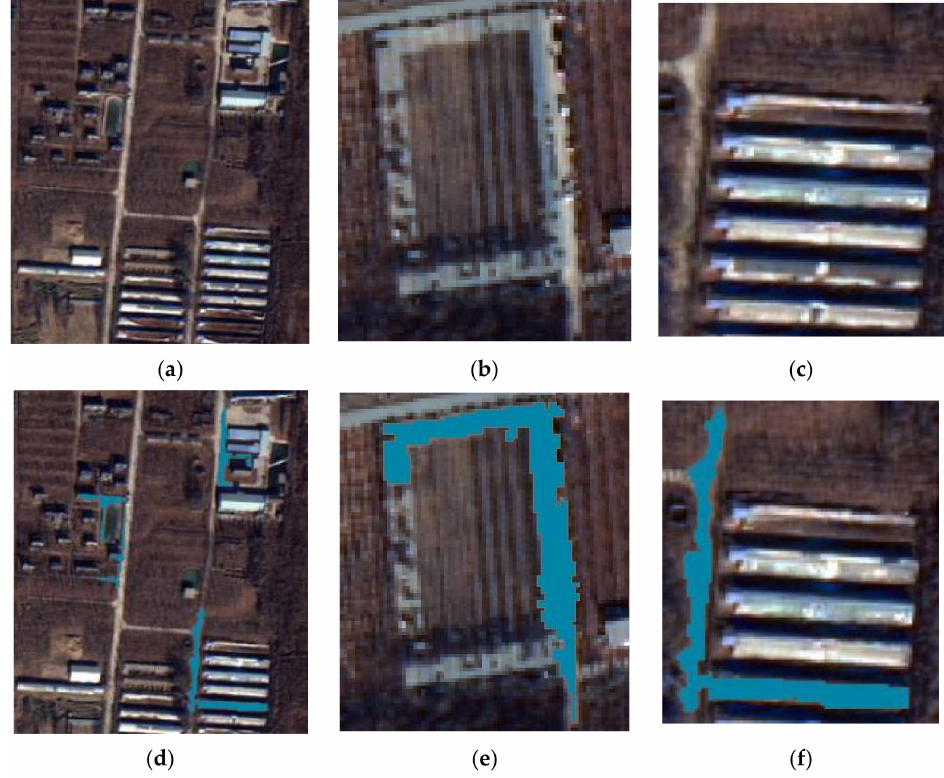
Figure 21. Classification results for the compactness: ( a – f ) Polygon compactness was used to separate the image objects with low compactness, especially for image objects with the T or L shape in study area